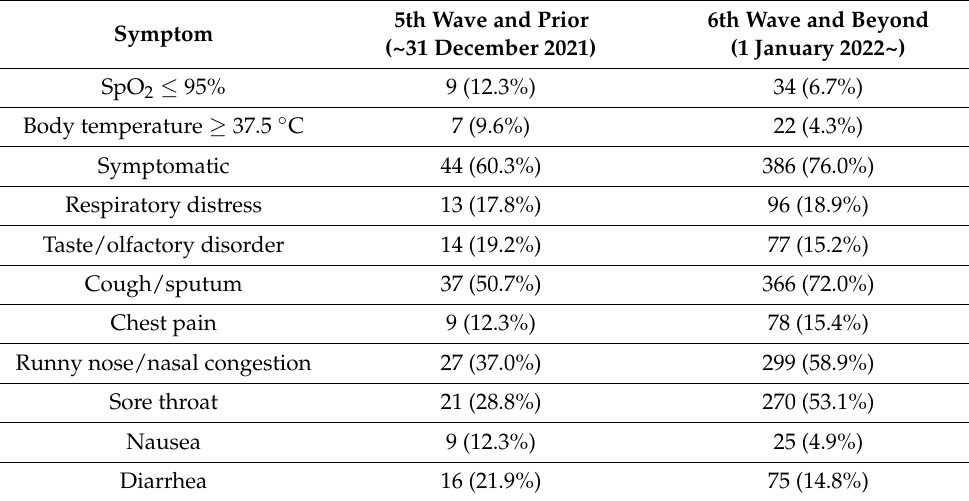
Table 4. Percentage of participants exhibiting each of the specific symptoms (aggregation of the responses obtained in the first